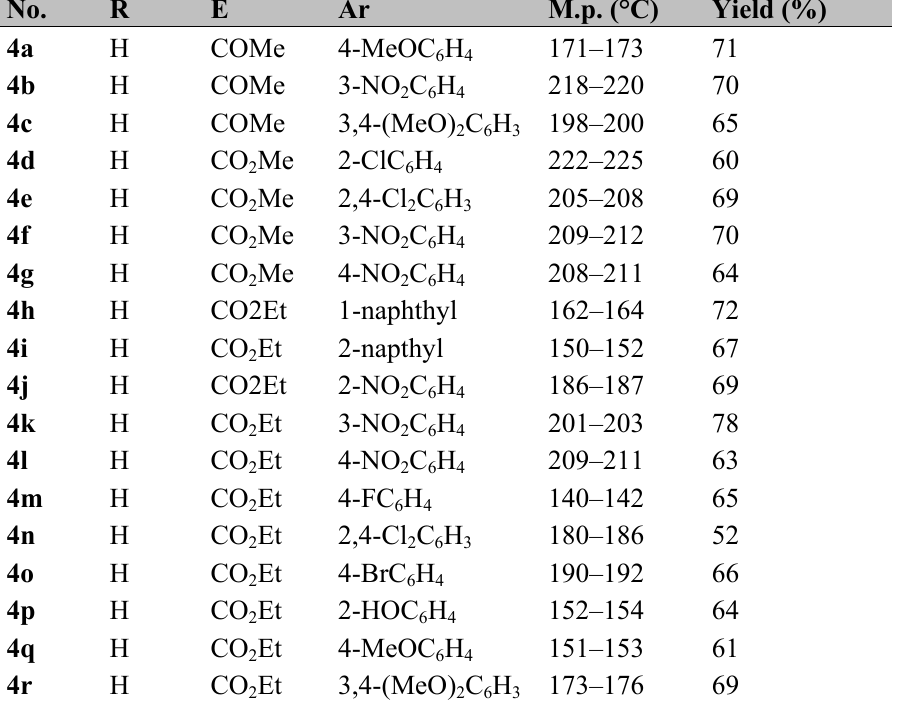
Table 1. New pyrrolo[2,1- a ]isoquinolines 4